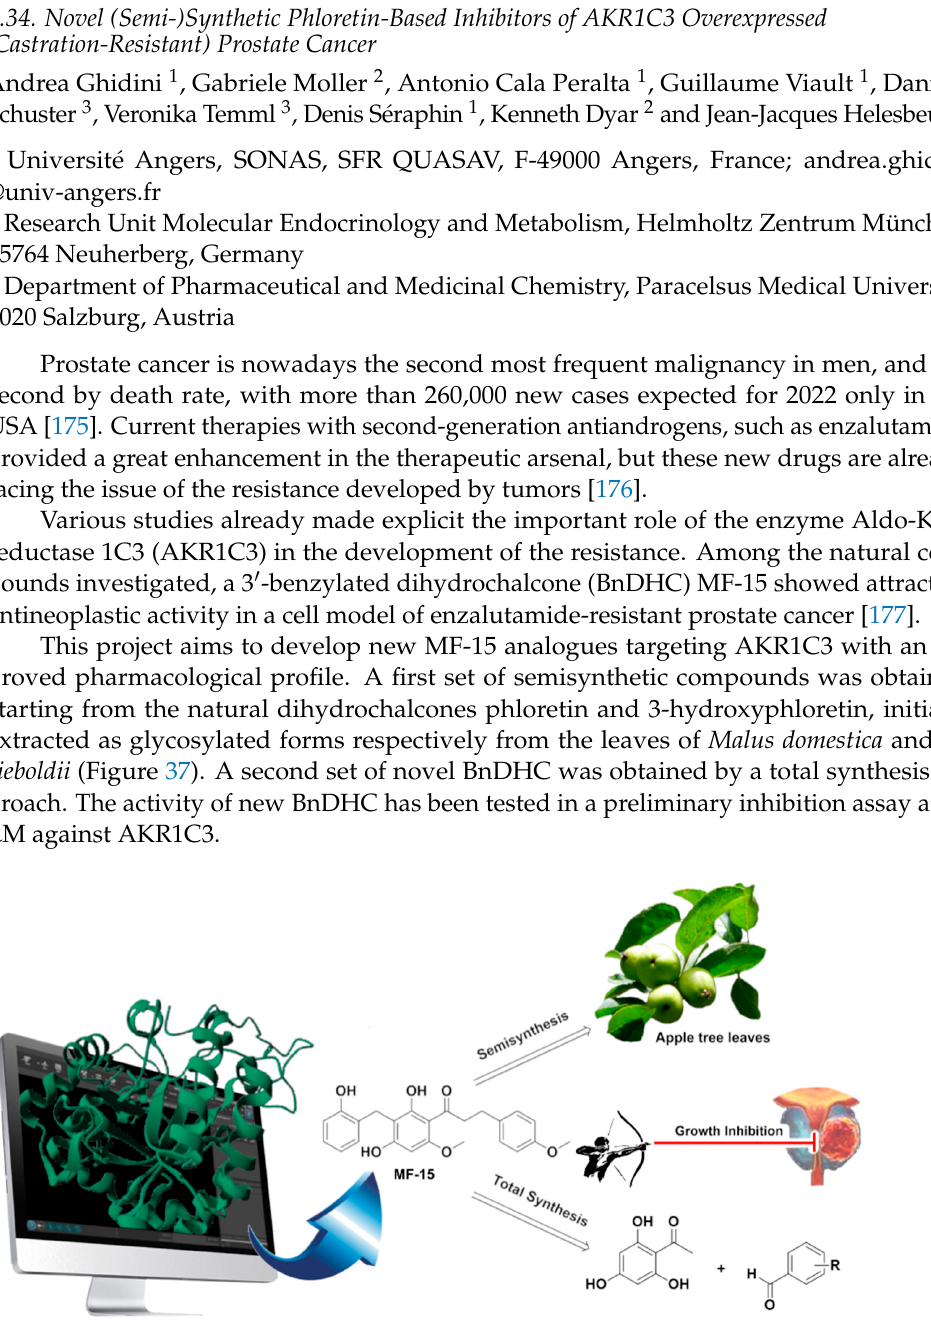
Figure 37. General strategy to develop new MF-15 analogues targeting AKR1C3 and limiting tumor growth .